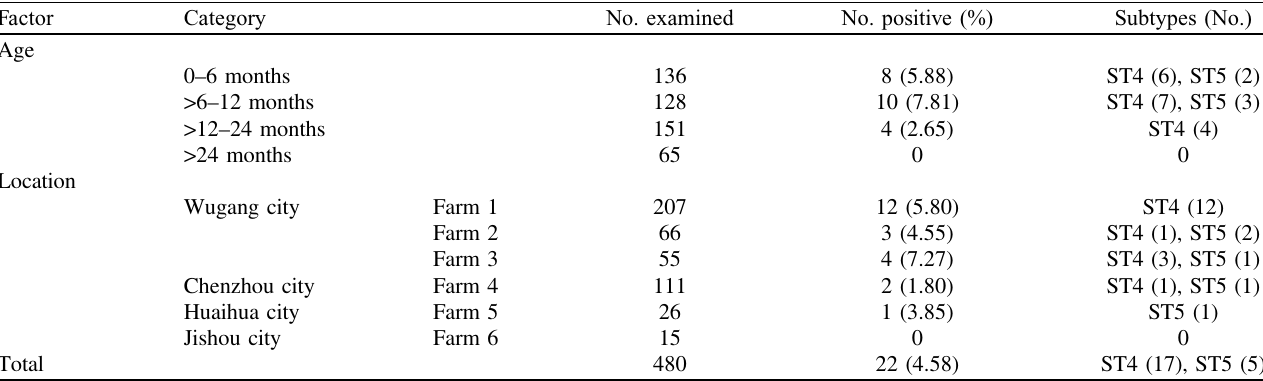
Table 1. Factors associated with prevalence of Blastocystis infection in Rhizomys sinensis in Hunan Province. Factor Category No.